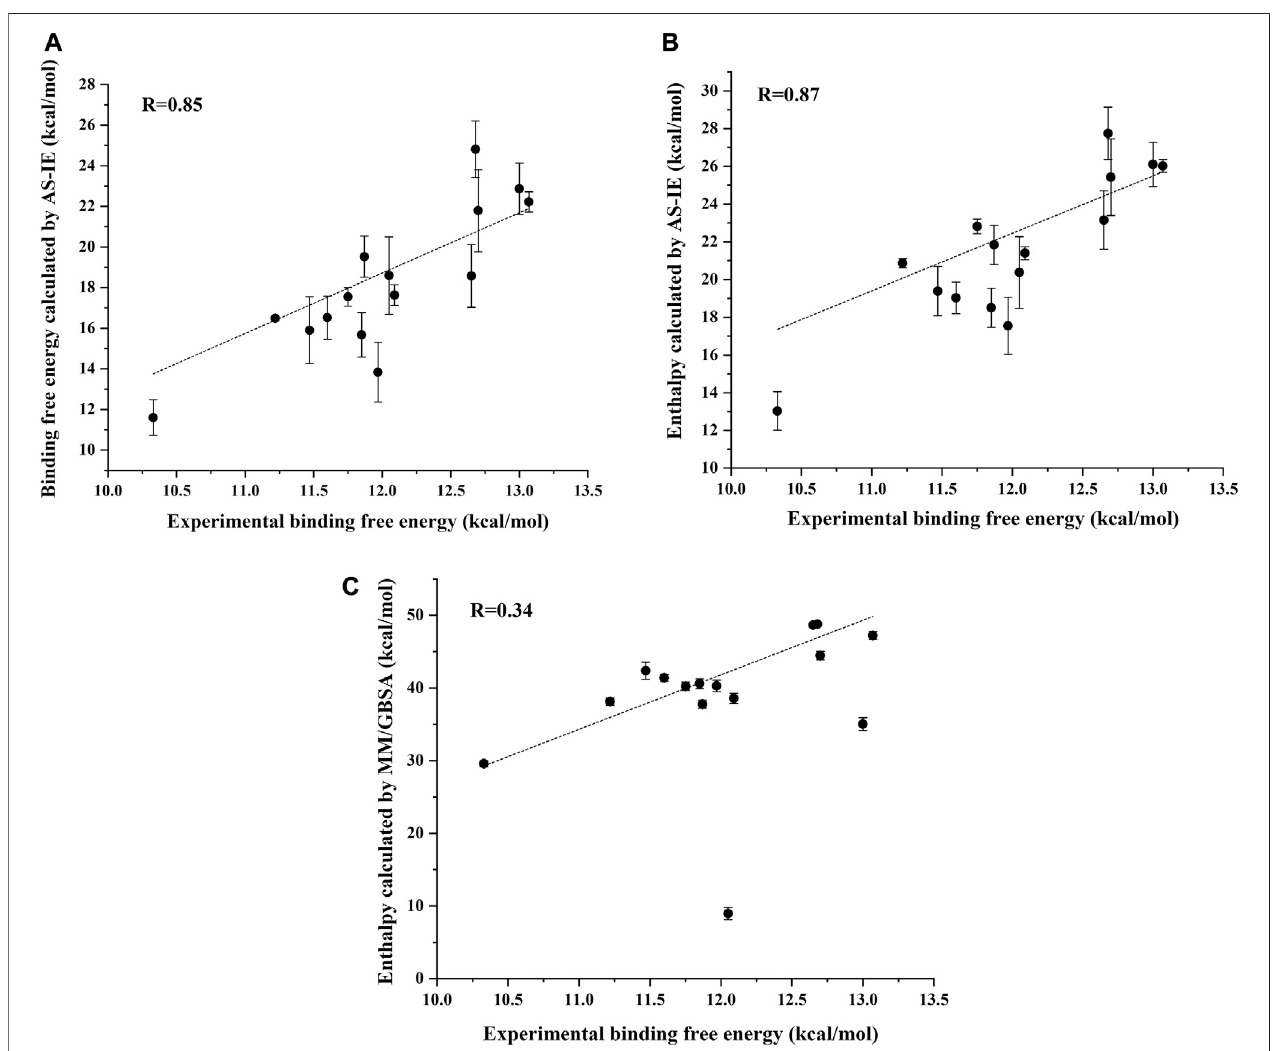
FIGURE 5 | Correlation coefficient R between the experimental binding energy and the binding free energy calculated by ASIE (A) , enthalpy calculated by ASIE (B) and enthalpy calculated by MM/GBSA method (C) .